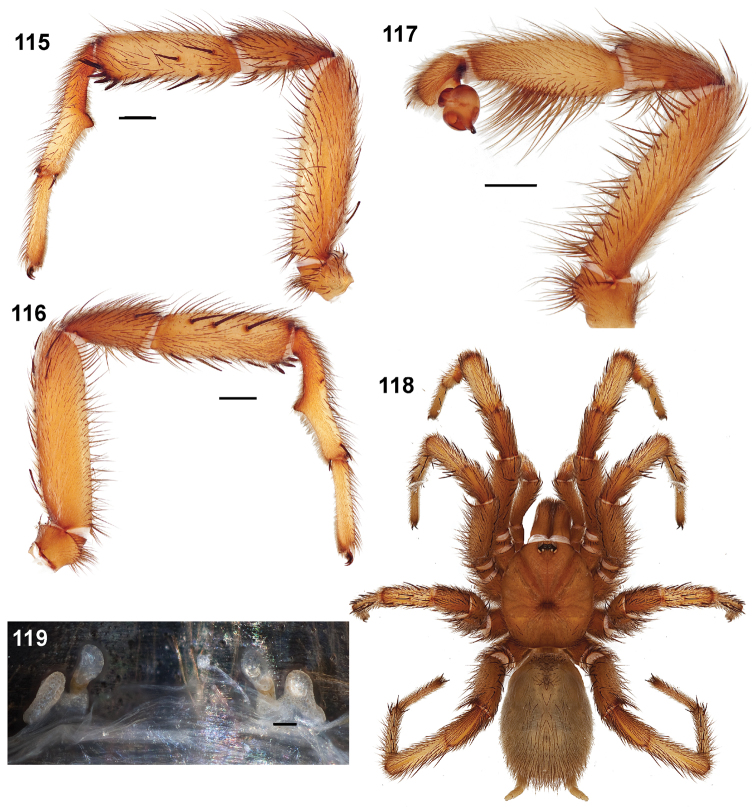
Aptostichus dantrippi sp. n. specimens from Kern Co., Bakersfield. 115–118 male holotype (AP179); scale bars = 1.0mm 115 retrolateral aspect, leg I [805816] 116 prolateral aspect, leg I [805820] 117 retrolateral aspect, pedipalp [805822] 118 male habitus [805824] 119 cleared spermathecae of paratype specimen (AP173) [806570]; scale bar = 0.1mm.